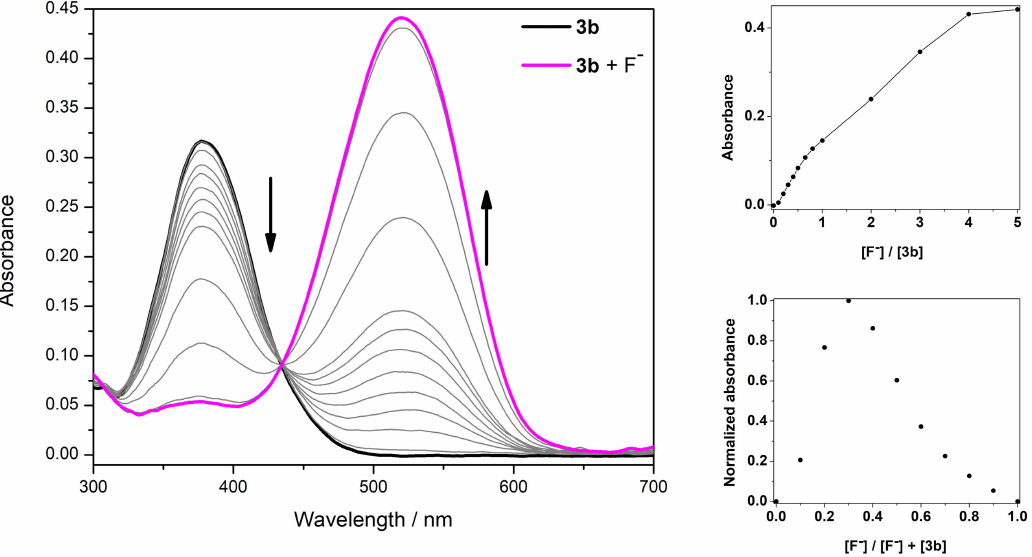
Figure 3. Photophysical interaction between compound 3b and F − (5 equiv. of F − required for maximum absorbance). Left —spectrophotometric titration of compound 3b with F − ; Top right —absorbance at 520 nm as a function of added ion equiv.; Bottom right —Job’s plot for the interaction (stoichiometry 3b 2:1 F −